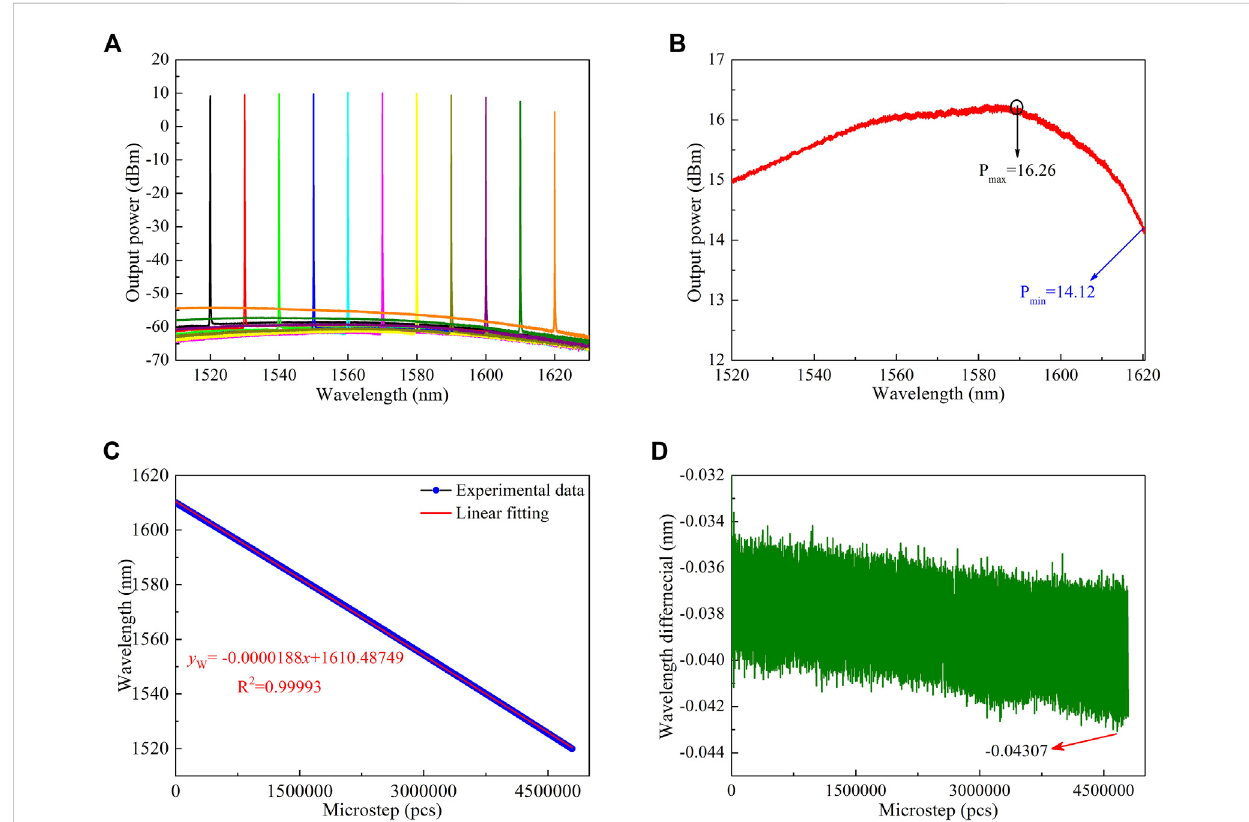
FIGURE 3 (A) Thesuperimposedopticalspectraatdifferentlasingwavelengths. (B) Outputpoweroftheproposed external-cavity wavelength-sweptlaser. (C) The relationship between the lasing wavelength and the physical length of the wavelength-swept laser cavity. (D) The mode-hopping free performance of the proposed external-cavity wavelength-swept